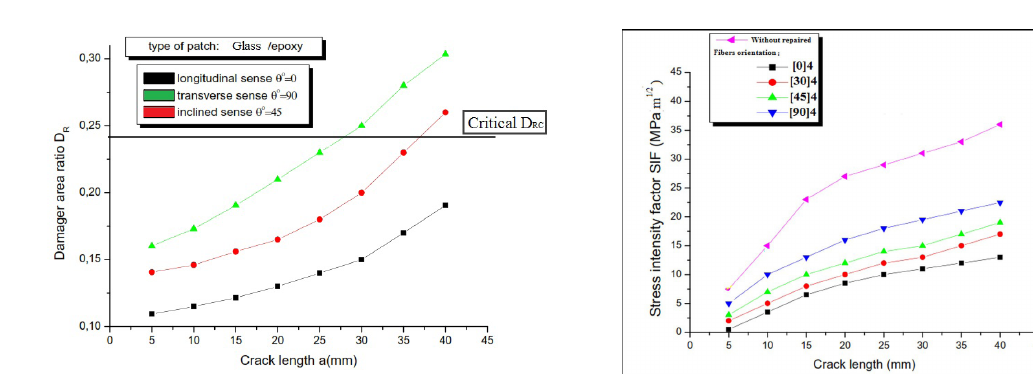
Figure 10. The damaged area of FM73 adhesive for a Glass / epoxy patch of V-shaped.